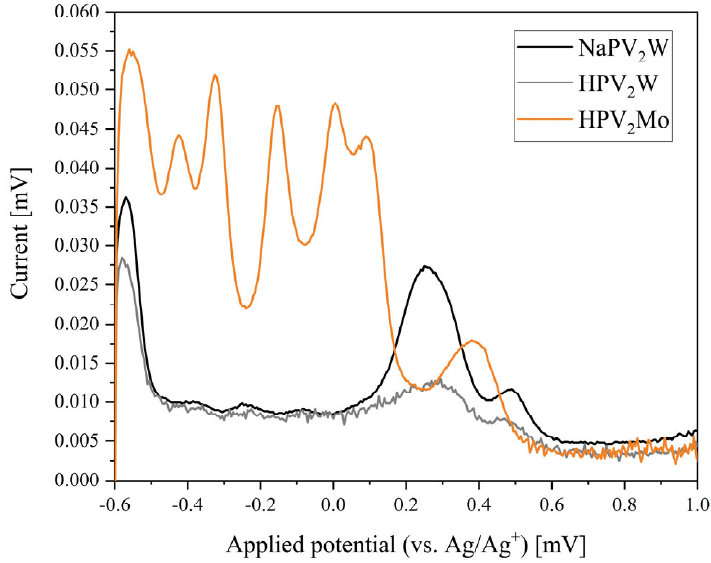
Figure 14. SWV data of the POMs NaPV 2 W, HPV 2 W, and HPV 2 Mo (concentration 1 mmol/L, scan rate 5 mV and pH 1 (HCl as supporting electrolyte)).